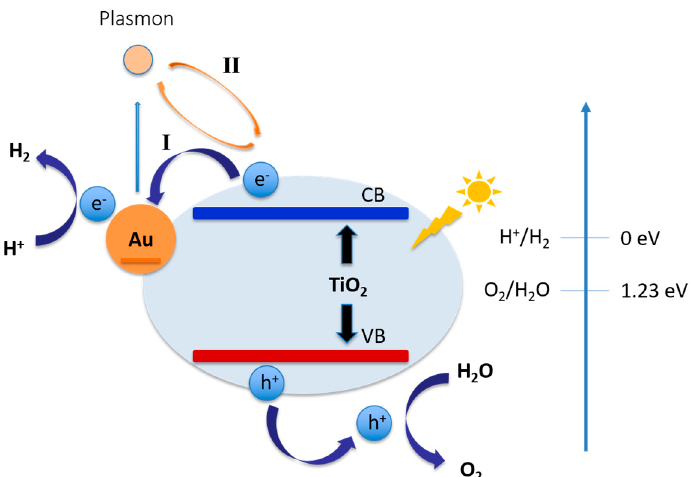
Figure 7. Schematic illustration of heterojunction between Au nanoparticles and TiO 2 semiconductors. Pathway I shows the extraction of photo-generated electron from TiO 2 conduction band to Au NPs. Pathway II shows the coupling of exciton of TiO 2 and surface plasmon of Au. Figure adapted from references [150,168] Chen et al. and Dutta et al works respectively.